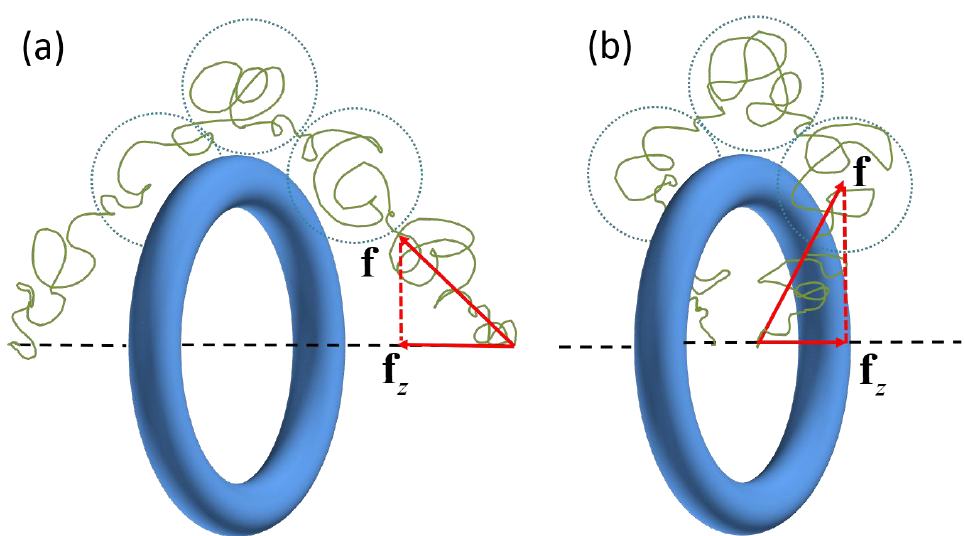
Figure 8. Schematic illustration of the force-direction reverse when 𝐿 decreases for the outward- winding entangling modes with ( a ) for the large 𝐿 region and ( b ) the small 𝐿 region.